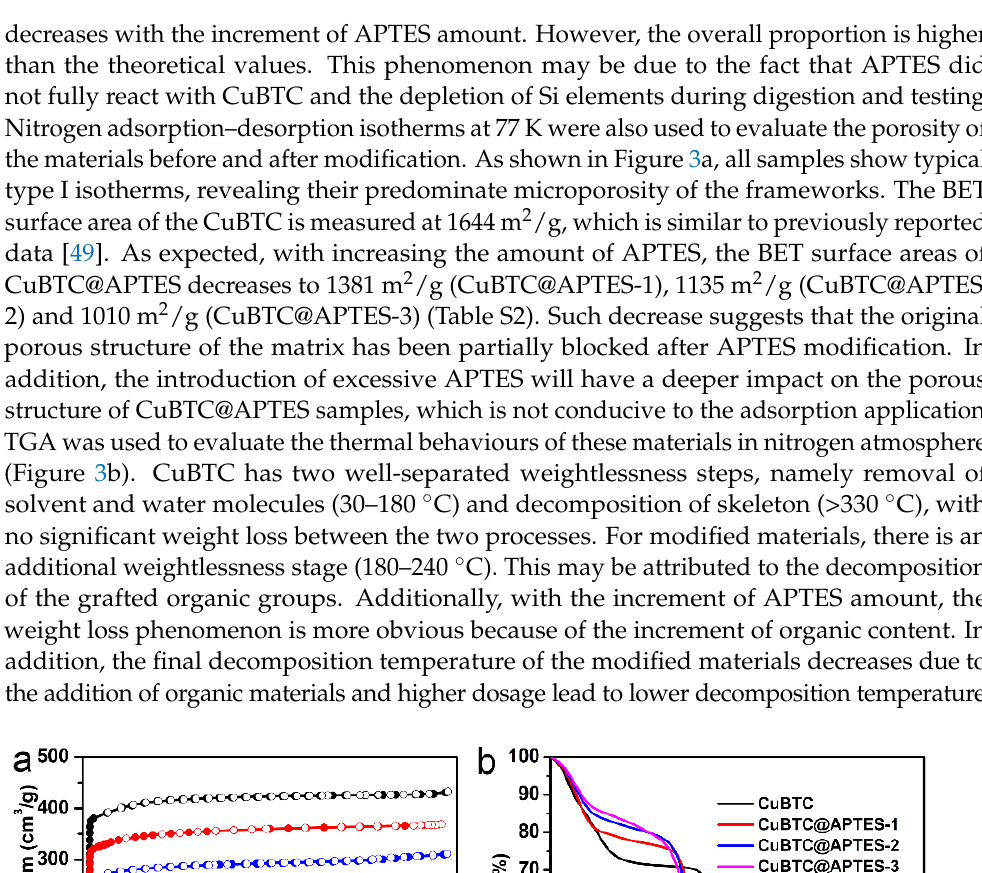
Figure 3. ( a ) N 2 adsorption–desorption isotherms of CuBTC and CuBTC@APTES; ( b ) TGA curves of CuBTC and CuBTC@APTES.